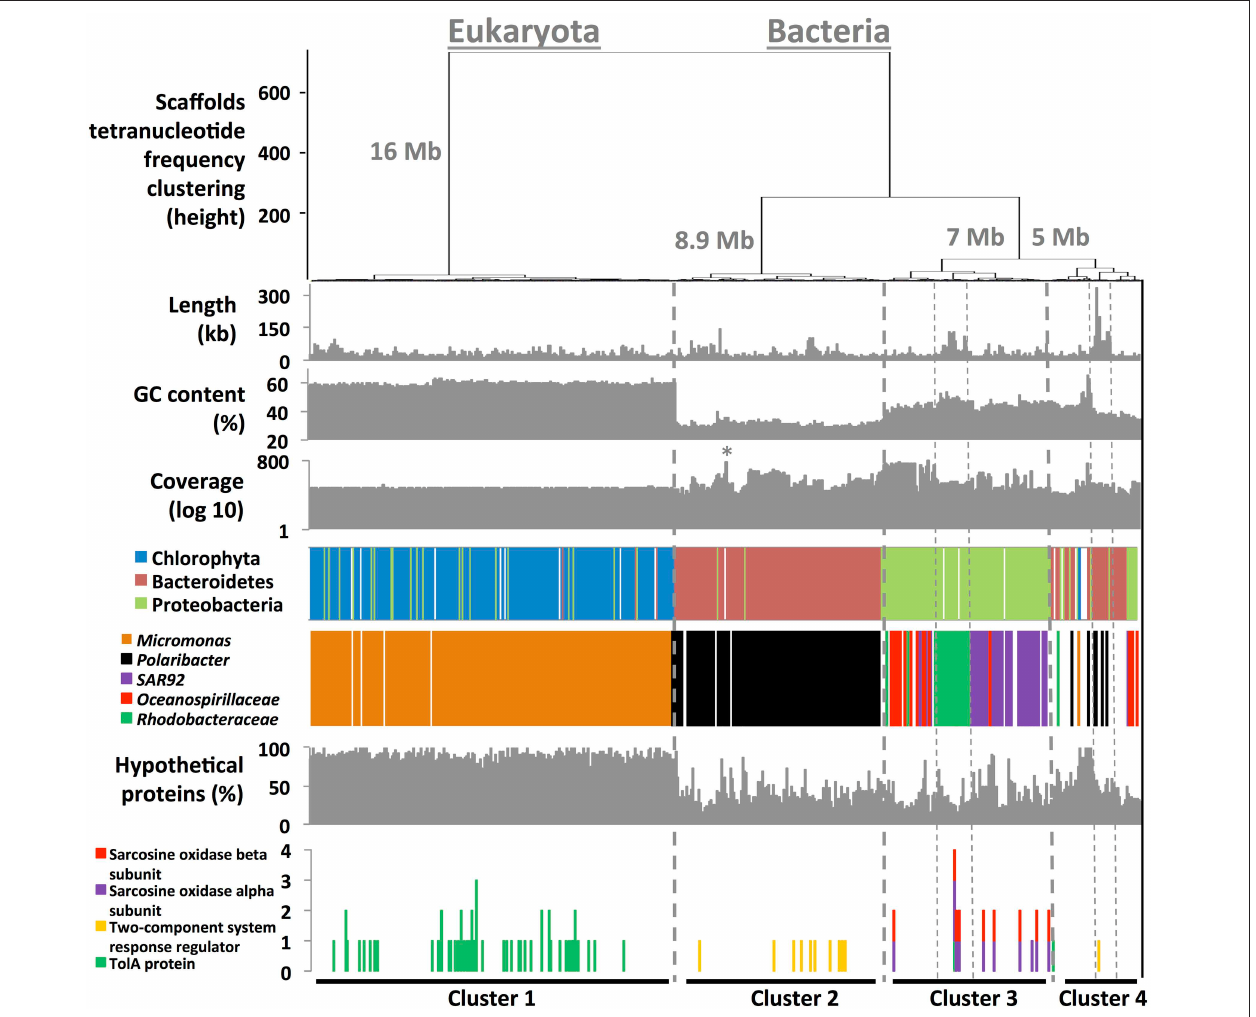
FIGURE 1 | Hierarchical clustering (Euclidean distance metric) of 1500 scaffolds (11.9–332.7kb in length) based on their tetranucleotide frequency profiles. Seven informative layers were added below to the clustering tree. Percentage of hypothetical proteins and the occurrence of specific functions were accessed using RAST (Aziz et al., 2008). Taxonomical affiliation was inferred using phymmBL (Brady and Salzberg, 2009). The * in coverage value layer represents Phaeocystis antarctica chloroplast scaffolds.